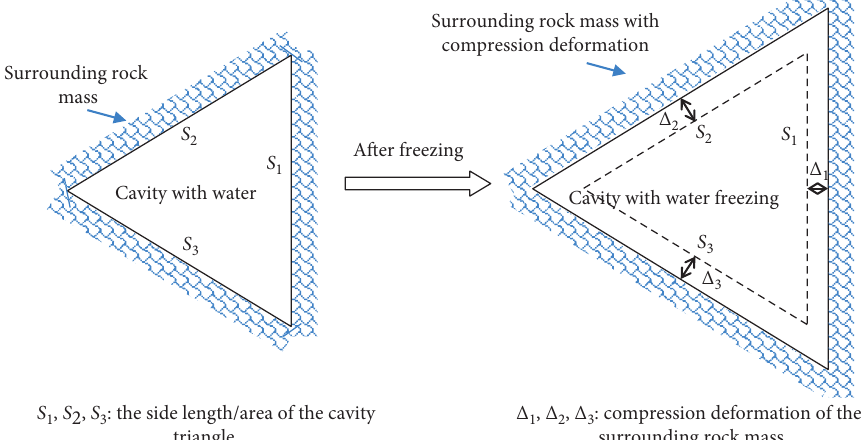
Figure 2: Schematic of the frost heaving of the triangular cavity as a result of internal water freezing.